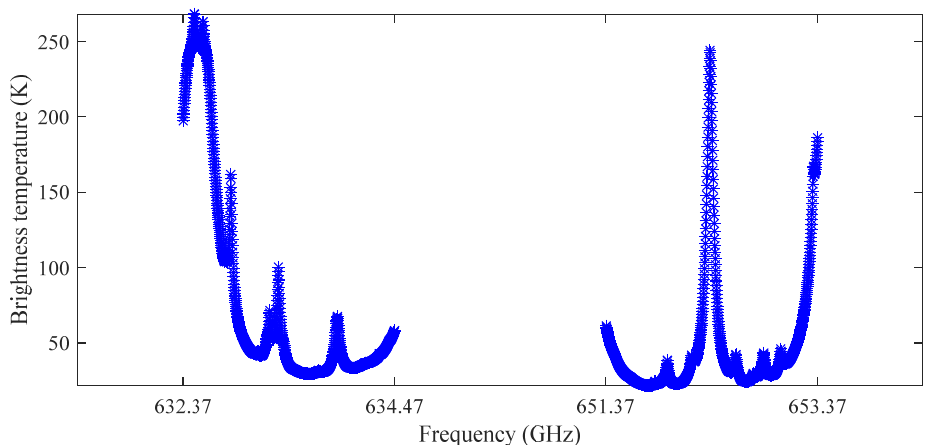
Figure 5. The simulated brightness temperature spectrums of 640 GHz S10 for both sidebands at the tangent height of 30 km.